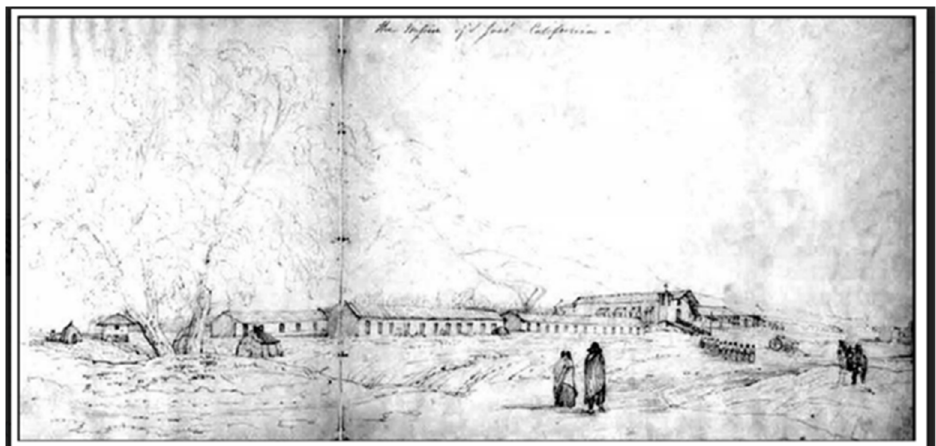
Figure 13. An early depiction of Mission San Jose’s long Native American quarters’ adobe architec- ture [22].